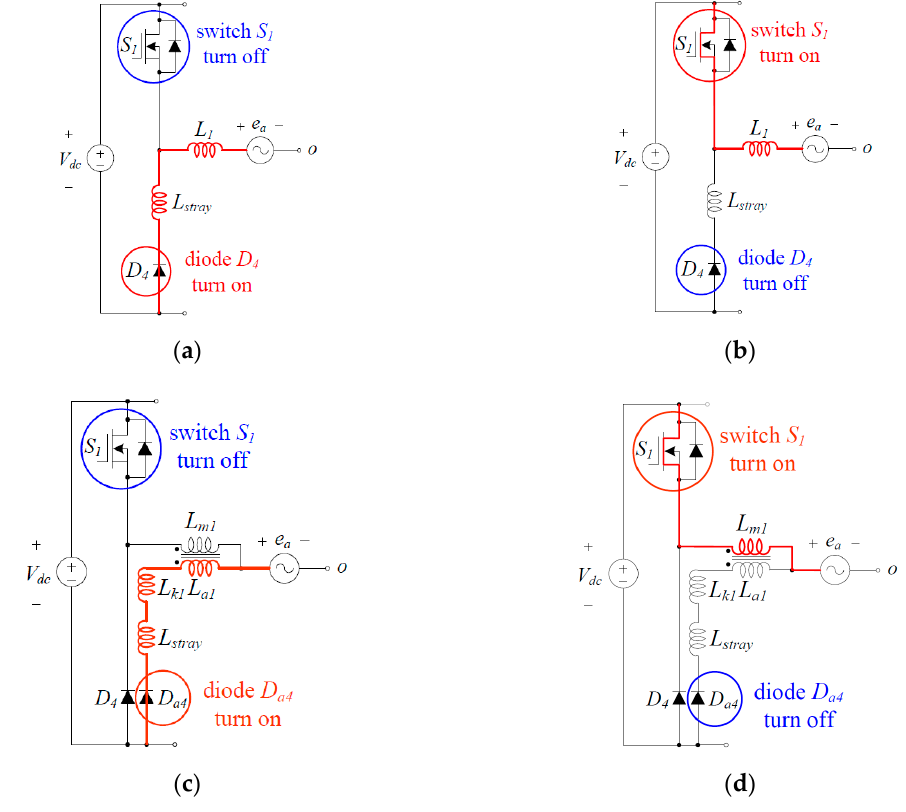
Figure 6. Switching characteristic of the SiC schottky diode for one switching leg: ( a ) D 4 turn on of the conventional inverter; ( b ) D 4 turn off of the conventional inverter ( c ); D a4 turn on of the proposed inverter; ( d ) D a4 turn off of the proposed inverter.